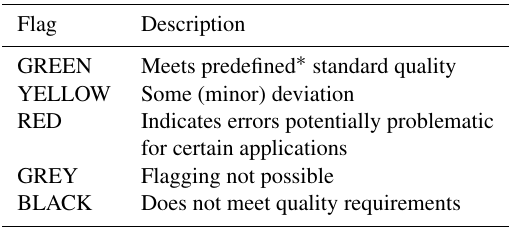
Table 1. General descriptions of the quality flags. Flag Description GREEN Meets predefined ∗ standard quality YELLOW Some (minor) deviation RED Indicates errors potentially problematic for certain applications GREY Flagging not possible